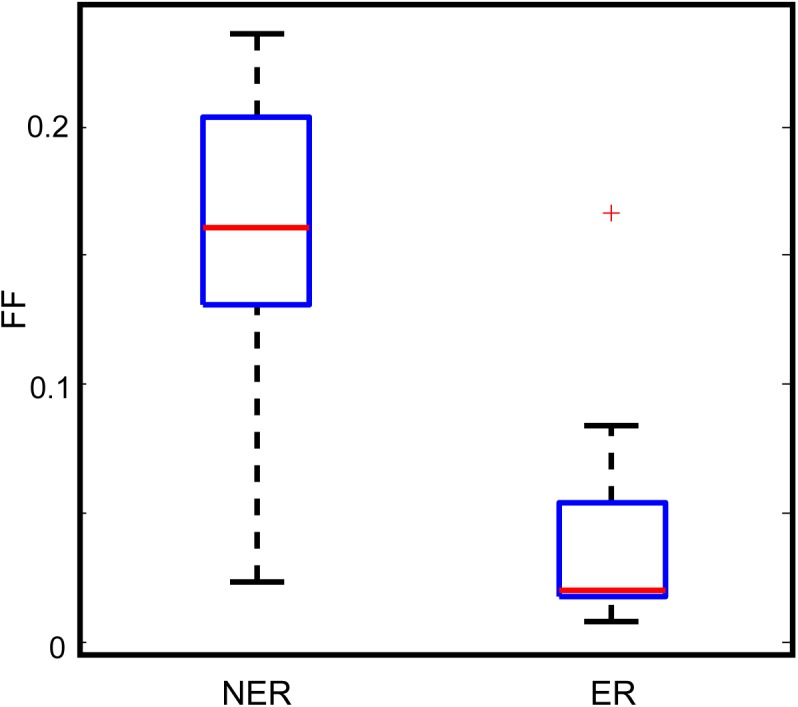
The FF values of the non-essential reaction (NER) group were generally higher than those of the essential reaction (ER) group.